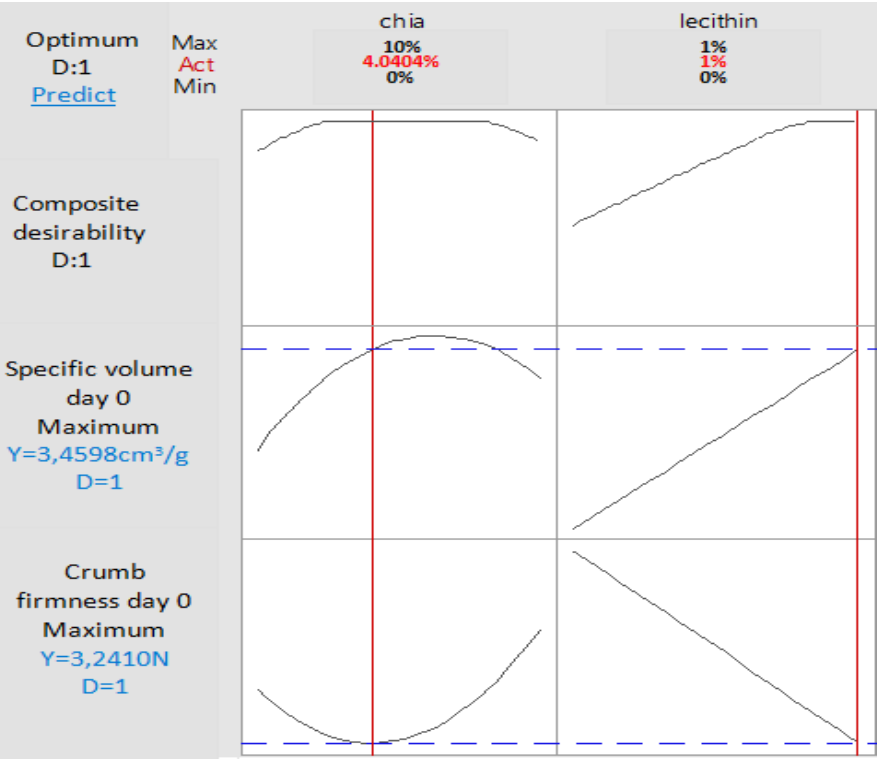
Figure 7. Optimized doses of chia and lecithin in order to maximize fresh bread specific volume and minimize its crumb firmness,